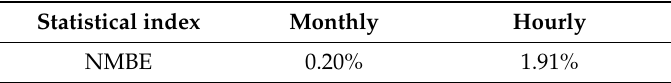
Table 1. Statistical index to compare energy consumptions of the reference building and the modified one.